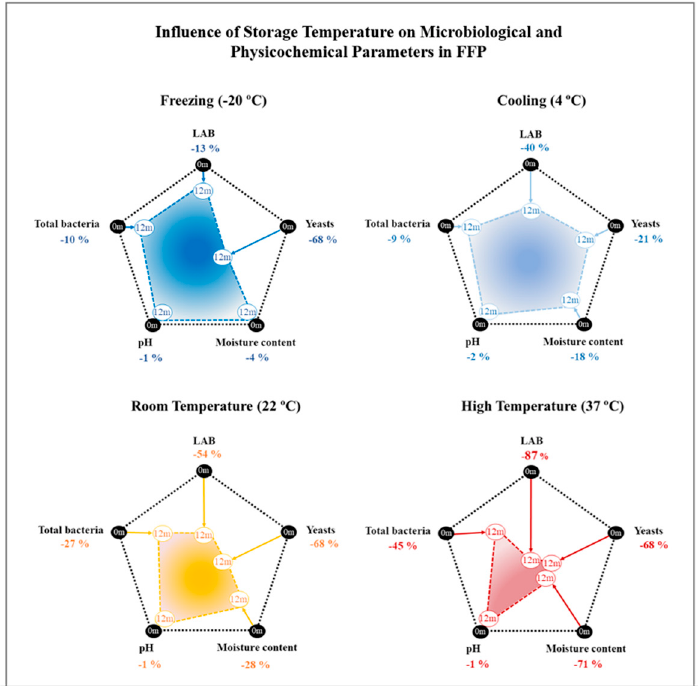
Figure 3. Overall influence of the analyzed temperature conditions on the microbiological profile and physicochemical properties of the fermented food product (FFP) following 12 months of storage. 0m: values obtained at the beginning of the study; 12m: values determined at the end of the study for each temperature condition. LAB: lactic acid bacteria.